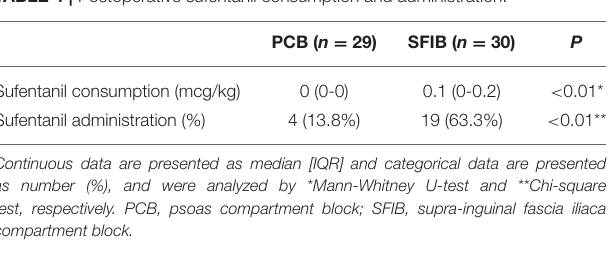
TABLE 4 | Postoperative sufentanil consumption and administration.